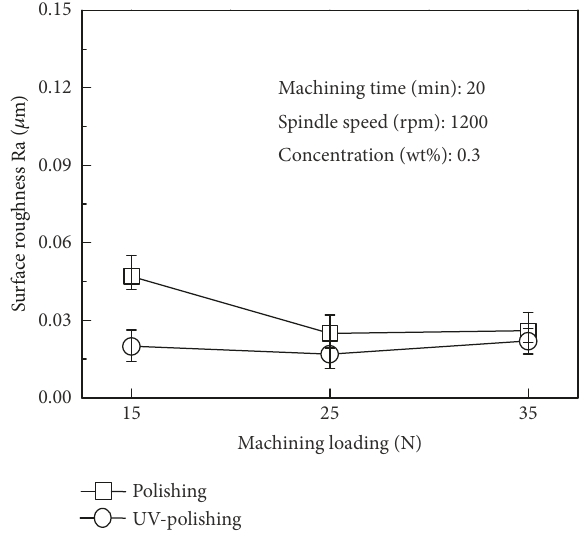
Figure 7: Impacts of loading on surface